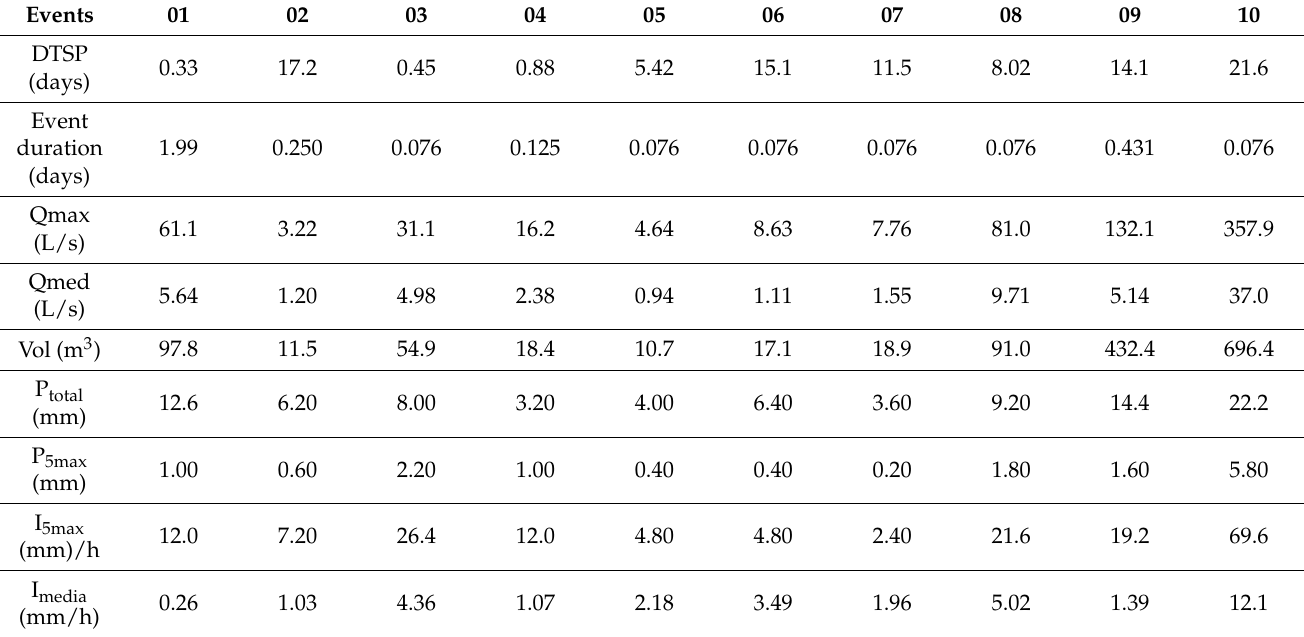
Table 2. Characteristics of rainfall events observed during the study